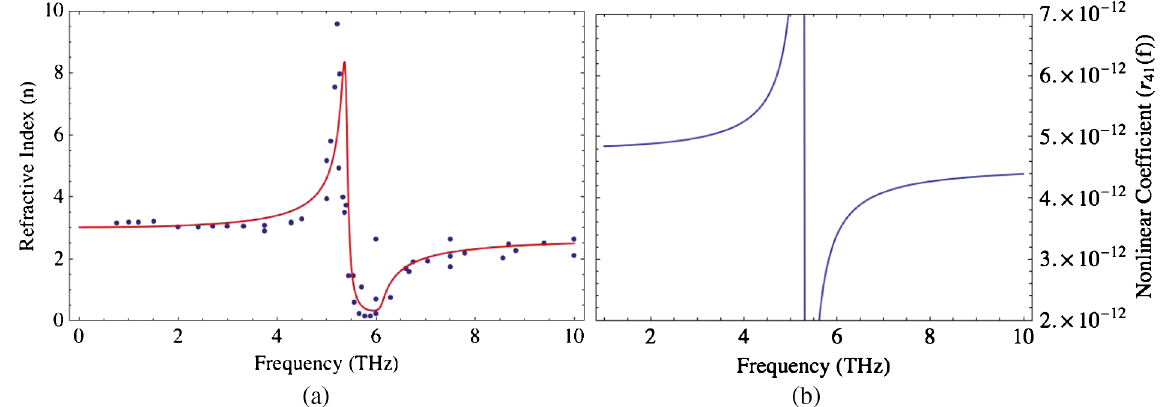
FIG. 1. Plots showing the refractive index (a) and electro-optic coefficient r 41 (b) of ZnTe at various frequencies